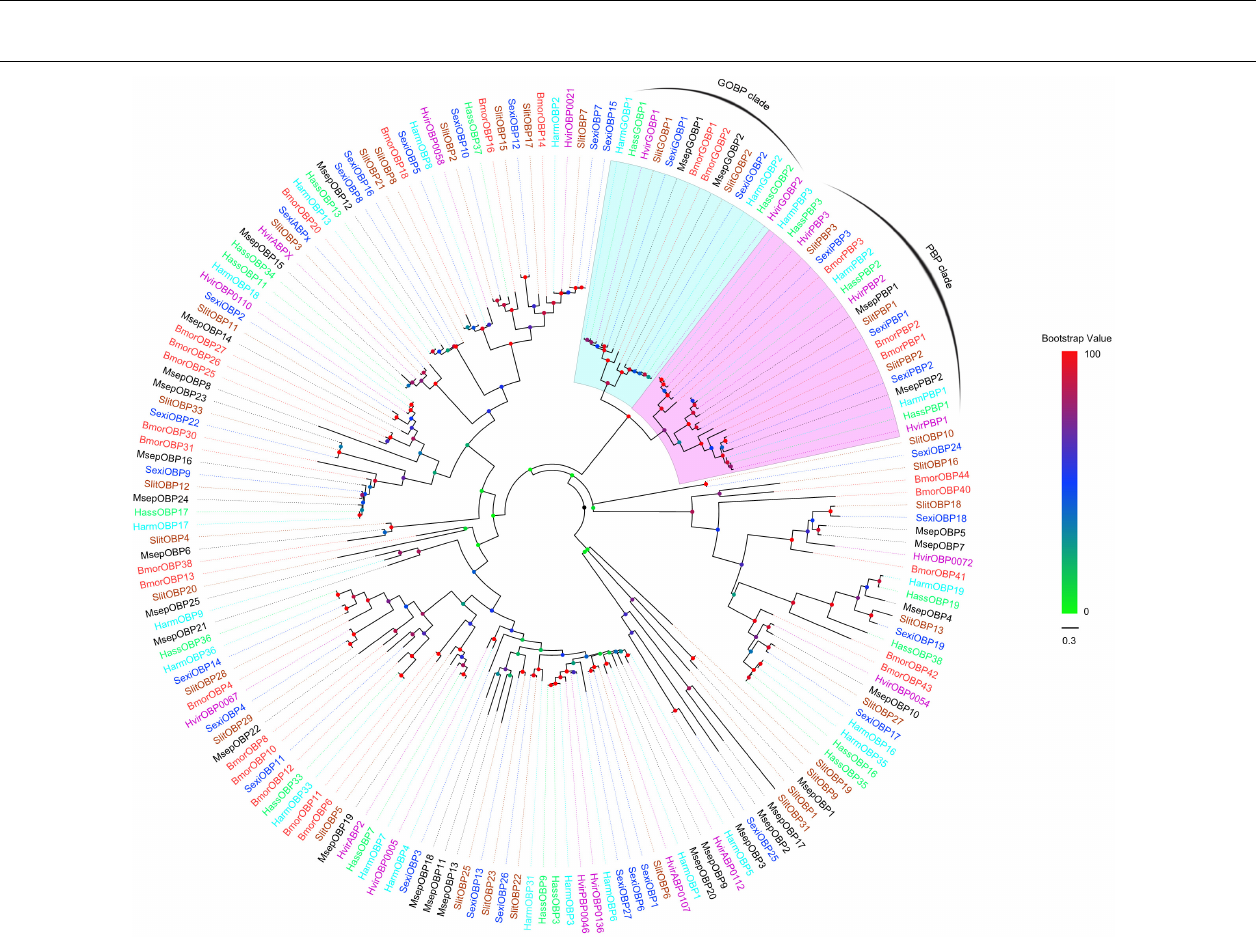
FIGURE 5 | Phylogenetic tree of putative OBPs from lepidopteran species. This tree was constructed using MEGA5.2 based on alignment results of MAFFT. Msep: Mythimna separata (black); Harm: Helicoverpa armigera (cyan); Hass: Helicoverpa assulta (green); Bmor: Bombyx mori (red); Hvir: Heliothis virescens (dark violet); Sexi: Spodoptera exigua (blue) Slit: Spodoptera litura (sandy brown). The clades in violet and light cyan represent general odorant-binding proteins and pheromone-binding proteins, respectively.